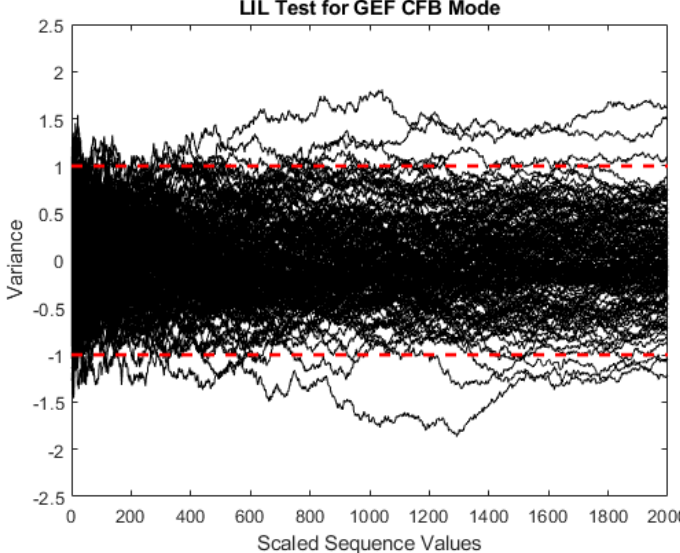
Figure 8. Variance plot resulting from Law of Iterated Logarithm Test on ECB Mode.